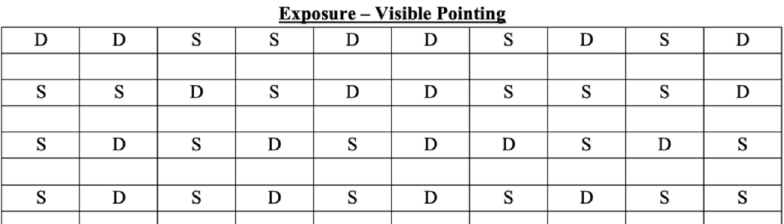
Figure 5. The fi gure shows the pointing movements performed in the post-adaptation phase. C = Figure 5. The figure shows the pointing movements performed in the post-adaptation phase. pointing movement toward the center. C = pointing movement toward the